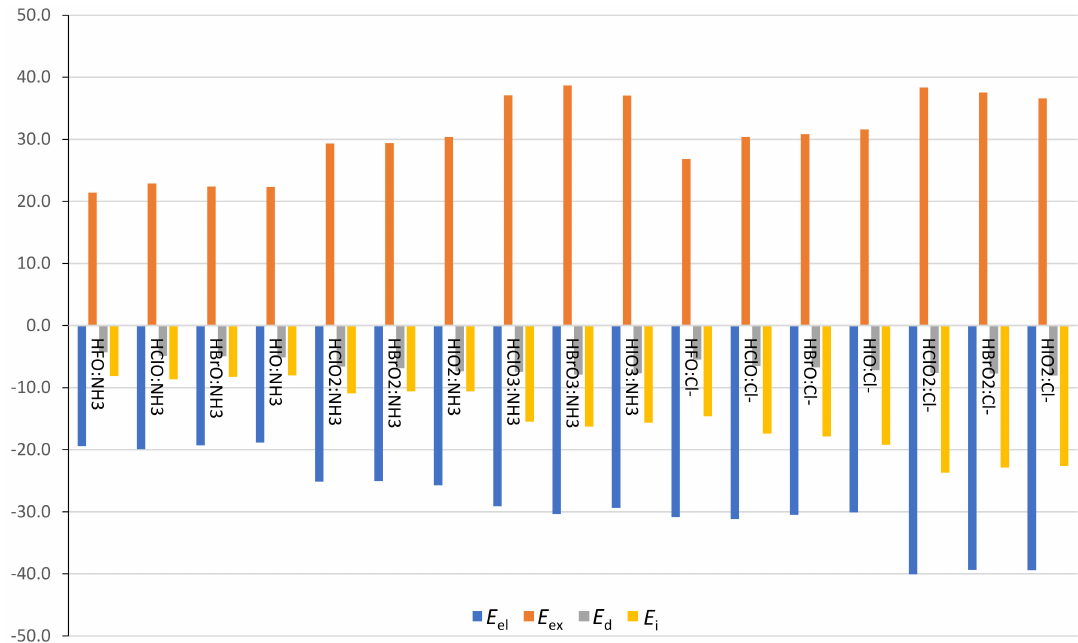
Figure 6. Symmetry-adapted perturbation theory (SAPT) electrostatic, exchange, dispersion, and induction energy contributions ( E el , E ex , E d , and E i , respectively) of HB complexes. Energies in kcal · mol − 1 .